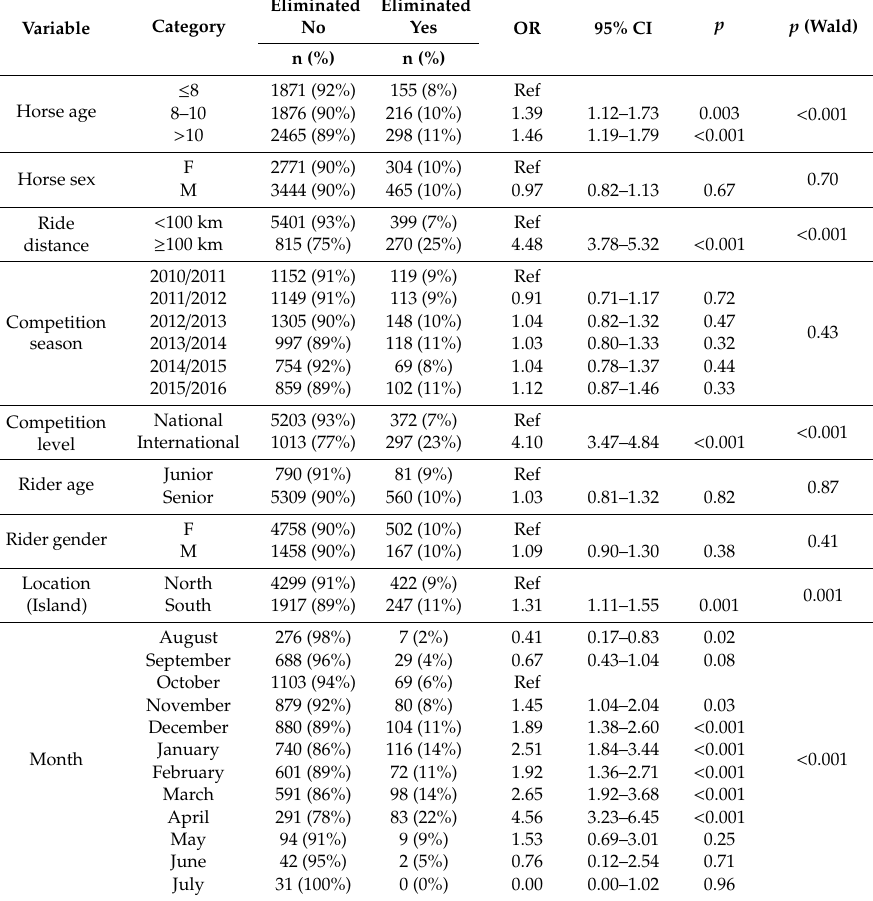
Table 3. Univariate logistic regression of associations between ride elimination (No / Yes) due to lameness reasons only and the predictor variables; horse age and sex, ride distance ( < 100 km or ≥ 100 km), competition season, competition level (national or international), rider age (junior or senior), rider gender, location (North or South island of New Zealand) and month of year.